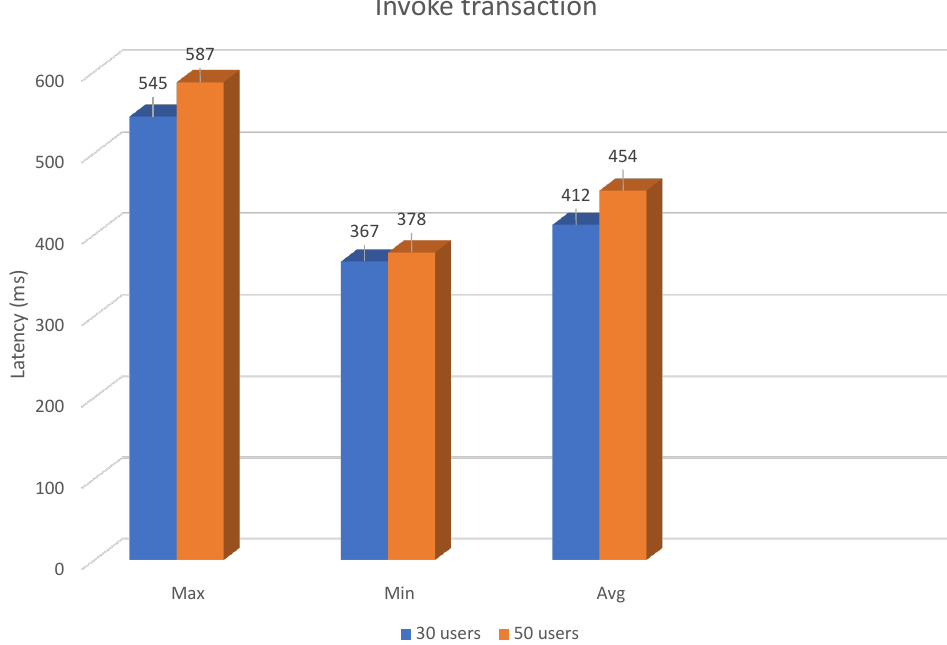
Figure 4. Latency in invoke transaction.